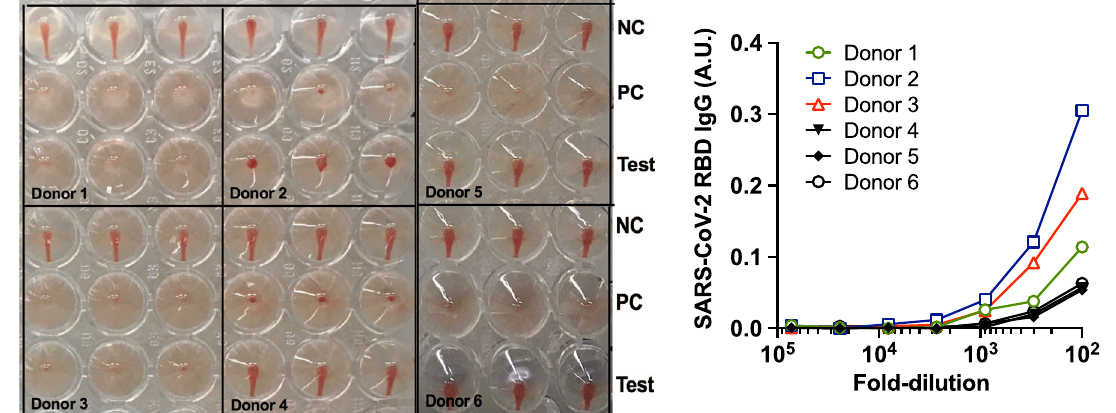
Fig. 6 HAT as a point of care test. Capillary blood samples were obtained by Lancet. Antibodies to the RBD were detected by HAT on autologous red cells in the sample in “ Test ” wells (plasma at 1:40) after addition of 100 ng/well IH4-RBD (see “ Methods ” ). NC negative control (PBS replaces IH4-RBD), PC positive control (20 ng/well CR3022, an anti-RBD monoclonal antibody added). In parallel, after removal of red cells, the plasma was tested in a standard ELISA for detection of antibodies to the RBD. Low levels of antibody detected in the ELISA were suf fi cient to give a positive result in the HAT. Detection of antibodies by HAT on autologous red cells obtained by fi nger prick has been repeated multiple times in both Oxford and Toulouse, and will be the subject of a future report. Source data are provided as a Source Data fi